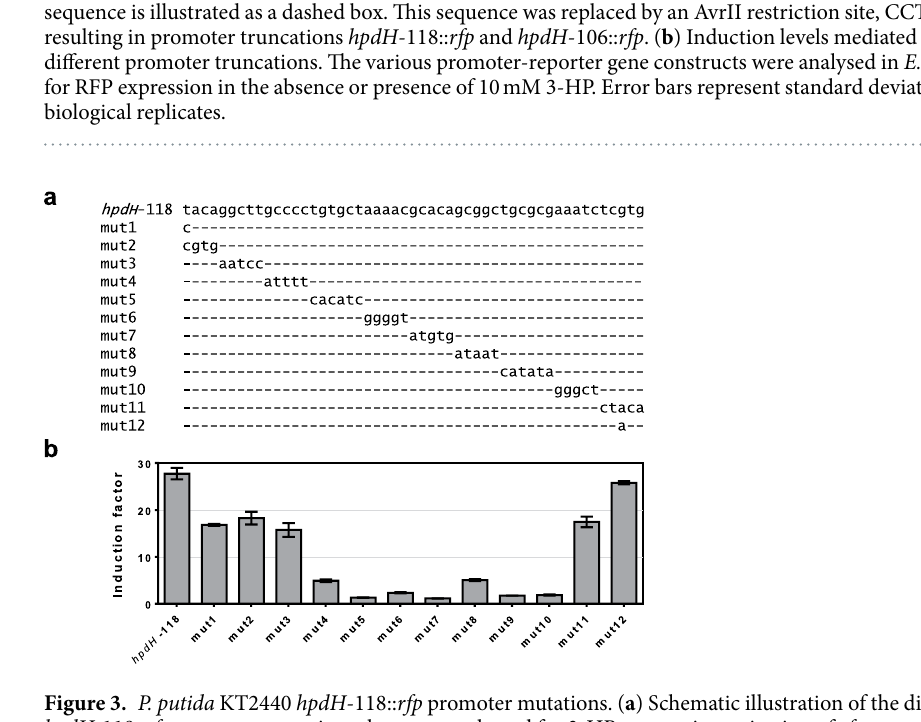
further truncation of the hpdH promoter by 12 nucleotides ( hpdH -106:: rfp ) results in a 10-fold decrease of induc- tion compared to that of hpdH -233:: rfp . Since hpdH -118:: rfp demonstrates similar induction levels to the native, untruncated intergenic region, it was subsequently used to generate hpdH promoter mutants. The use of random mutagenesis was deemed to be a combinatorial challenge, seeking to achieve a full set of completely random mutants covering the 60 bp long conserved motif. Therefore, mutations were designed in such a way that they enabled a complete coverage by employing a mutagenesis strategy, which has been reported previously 47 . In total, twelve promoter variants were constructed, harbouring single or multiple nucleotide mutations between position − 118 and − 68 (Fig. 3a). They were analysed in E. coli MG1655 for reporter gene expression in the presence and absence of 3-HP (Fig. 3b). By comparing the sequence similarity motif (Fig. 1d) with the induction levels of the different promoter variants, it can be observed that the extent of nucleotide conservation correlates with their importance for inducible gene expression. Mutations 1, 2, and 3, which are upstream of the − 109 - − 68 region, show a minor impact on pro- moter activity (1.5- to 1.7-fold decrease in induction) compared to hpdH -118:: rfp . Mutations 4, 8 and 11, which are located in less conserved stretches of the − 109 - − 68 region, decrease induction of reporter gene expression by 5.5-, 5.4- and 1.6-fold, respectively. The remaining five mutations, 5, 6, 7, 9 and 10 alter the most conserved nucleotides in either CRE1 or CRE2. These mutations abolish the ability of the promoter to mediate controllable gene expression by decreasing induction levels from 11.5- (mutation 6) to 25.2-fold (mutation 7). The in vivo